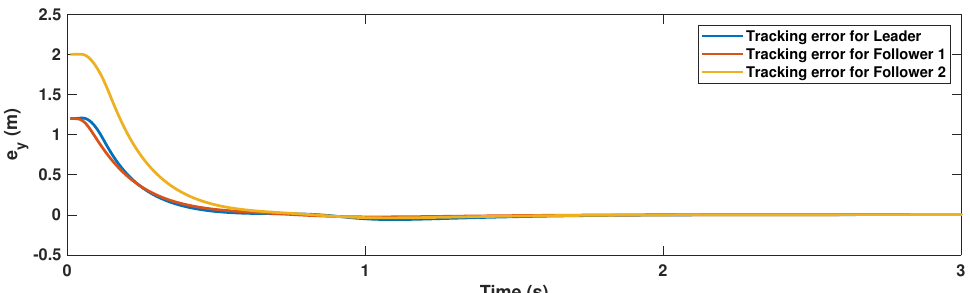
Figure 6. Path 1: The tracking error on the X-axis.